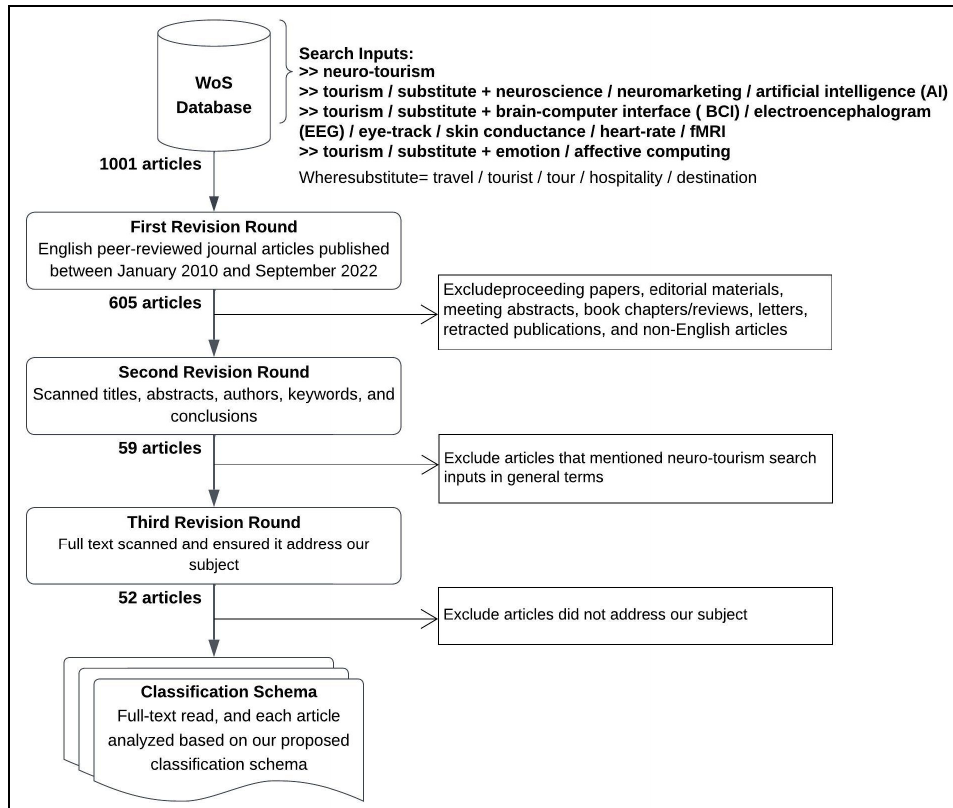
Figure 3. Research methodology.